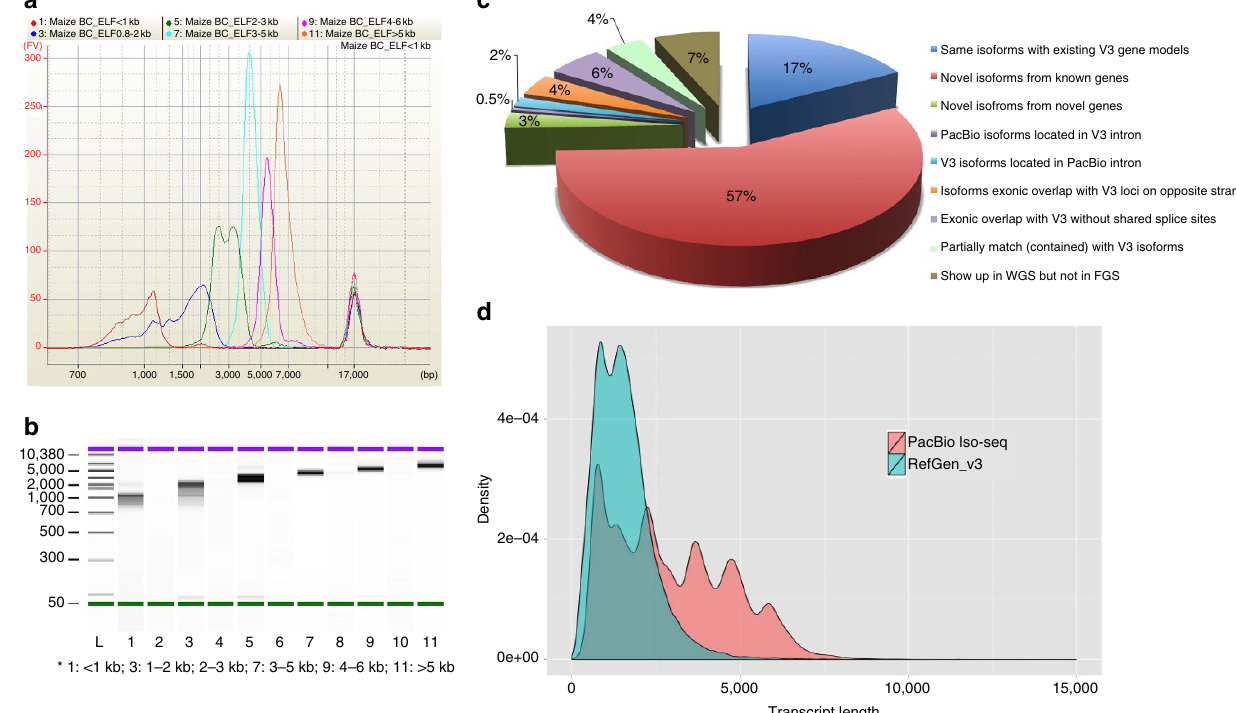
Figure 1 | Maize PacBio Iso-Seq barcoding library and comparison of isoforms between RefGen_v3 and PacBio data. ( a ) Quantification of six size-fractionated libraries on a Bioanalyzer chip. ( b ) Gel image of six size-fractionated libraries on a Bioanalyzer chip. ( c ) Comparison of PacBio and RefGen_v3 isoforms. ( d ) Comparison of isoform length between RefGen_v3 and PacBio data. NATURE COMMUNICATIONS|7:11708|DOI: